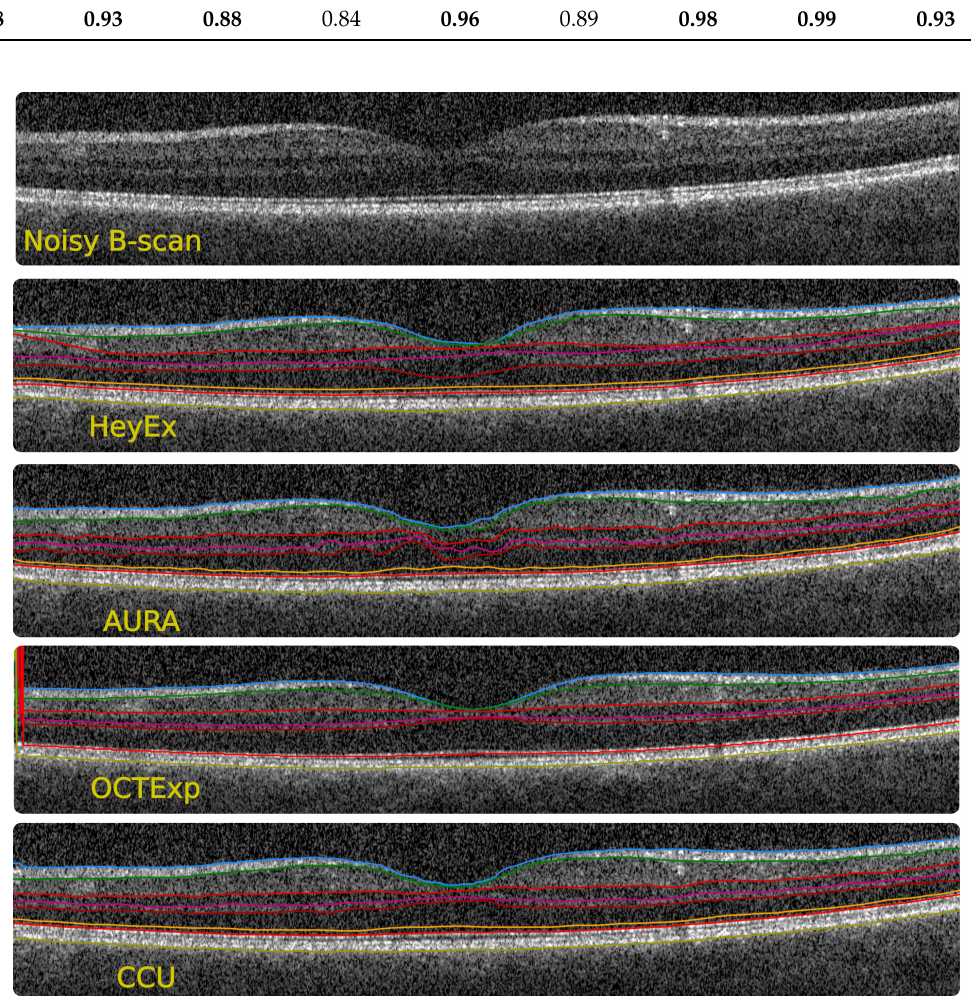
Figure 8. Example segmentation with a low-quality scan to show the performance of the pro- posed method compared to state-of-the-art methods (HeyEx—device segmentation, AURA [45], OCTExp